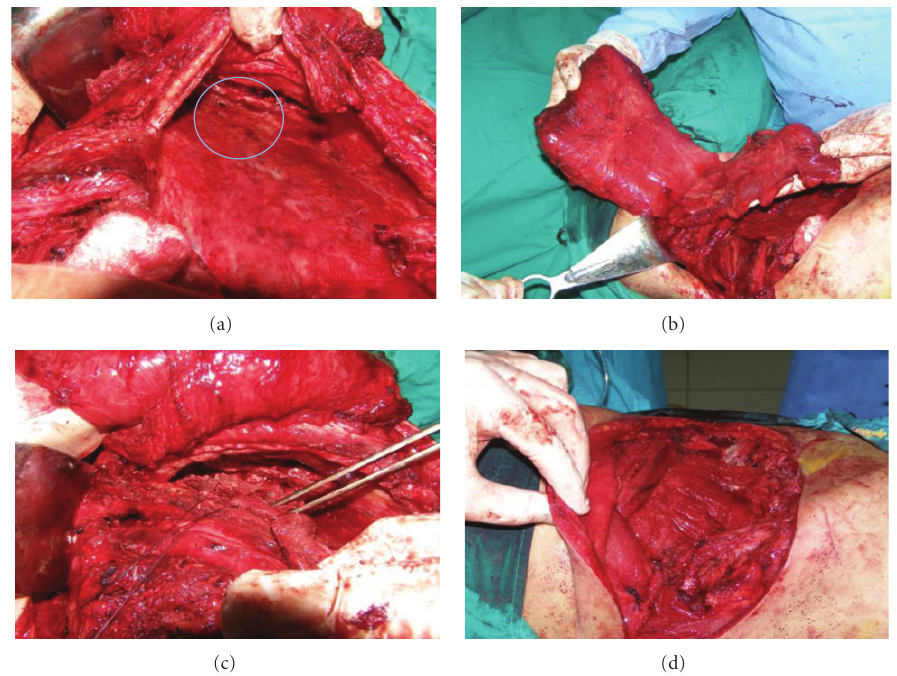
Figure 2: TB empyema with multiple bronchial fistulae solved by thoracomyoplasty—personal collection. (a) Aspect of the cavity with multiple large bronchial fistulae (encircled area). (b) The latissimus dorsi and serratus anterior flaps. (c) Closure-reinforcement of the bronchial fistulae. (d) Final aspect at the end of the procedure. Note the associated rib resection and the complete obliteration of the empyema cavity with the use of the muscle